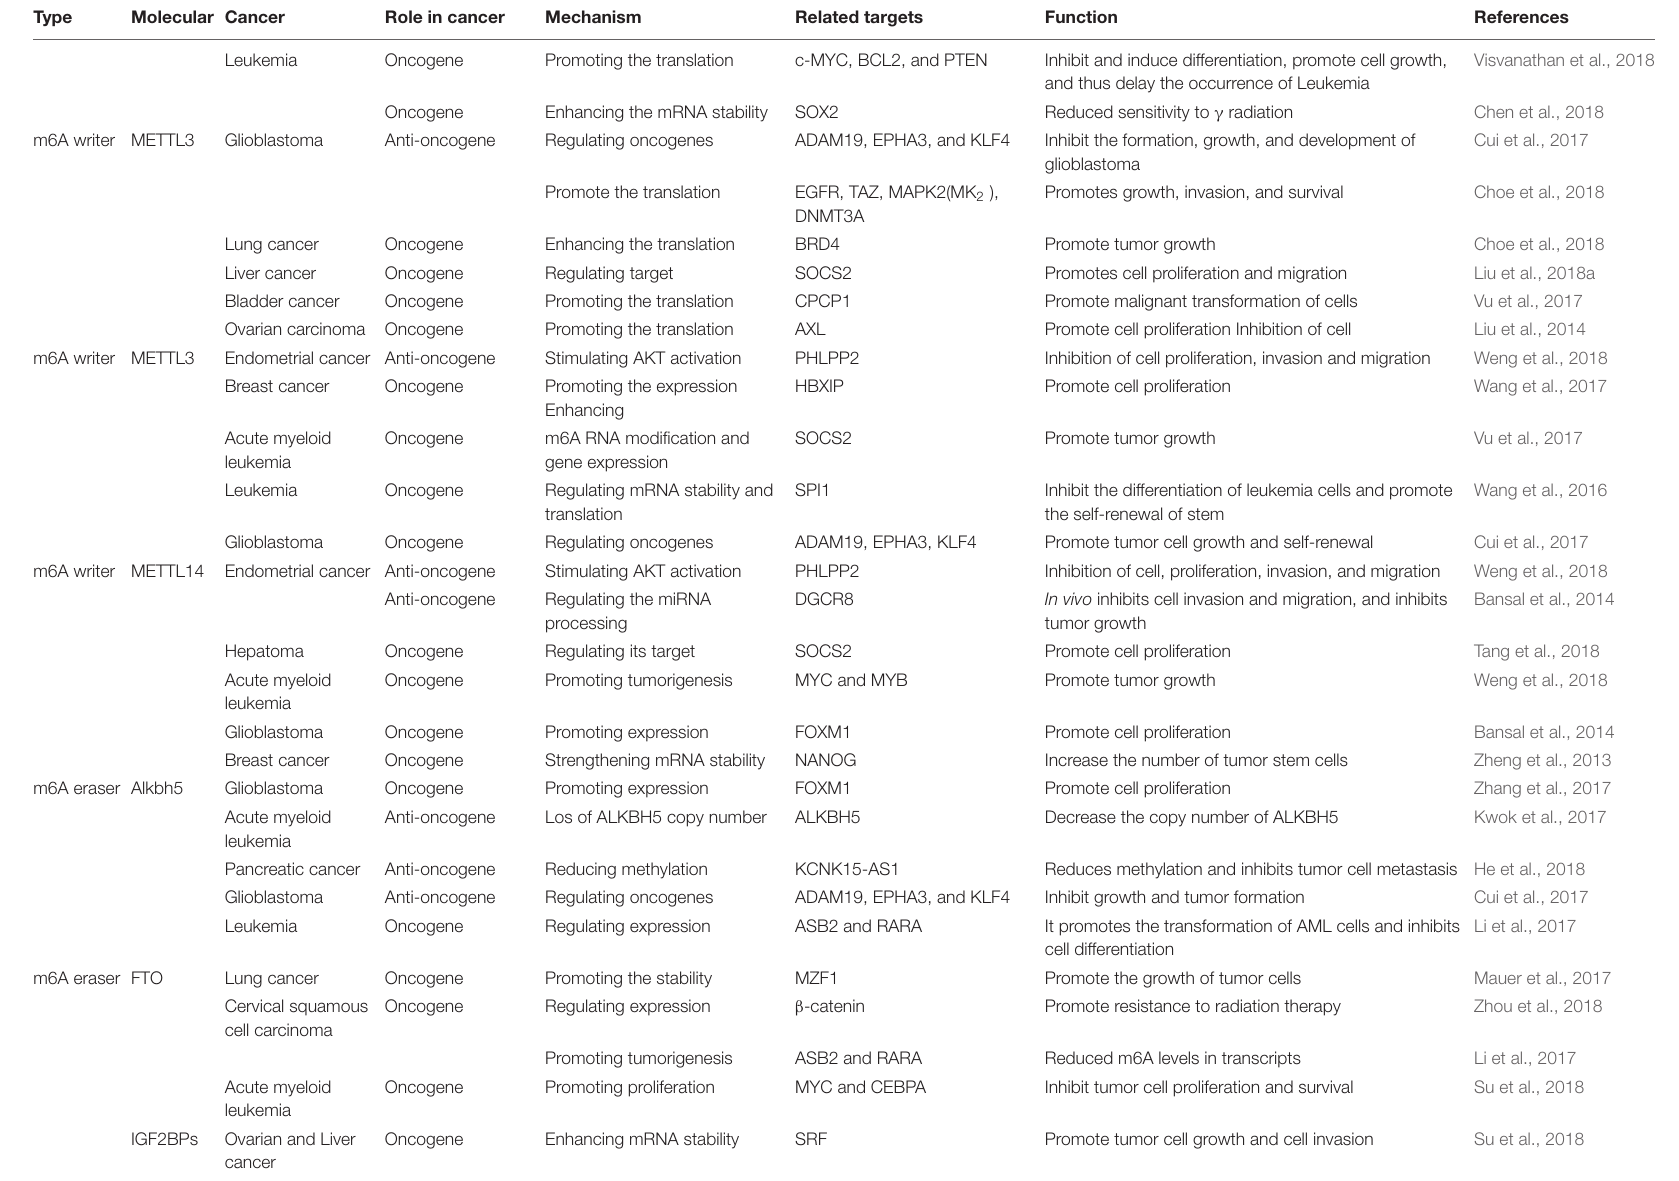
TABLE 1 | Tlie role of m6A methylation in a variety of